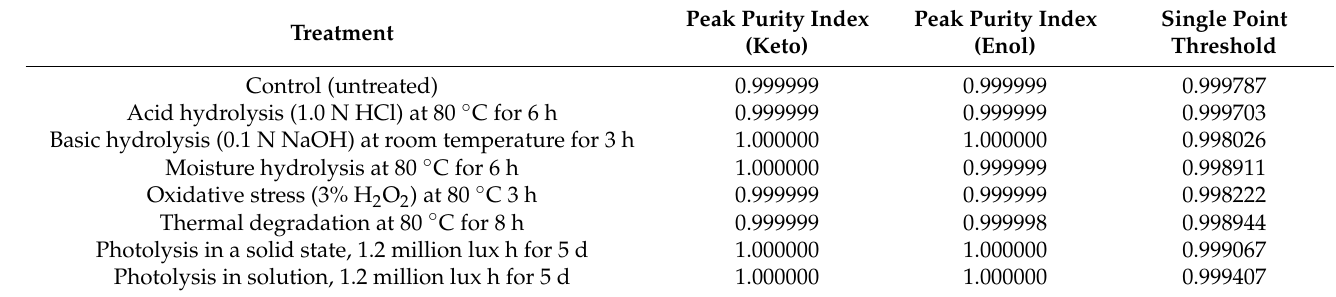
Table 2. Peak purity values of tetrahydrocurcumin di-glutaric acid (TDG) under stress